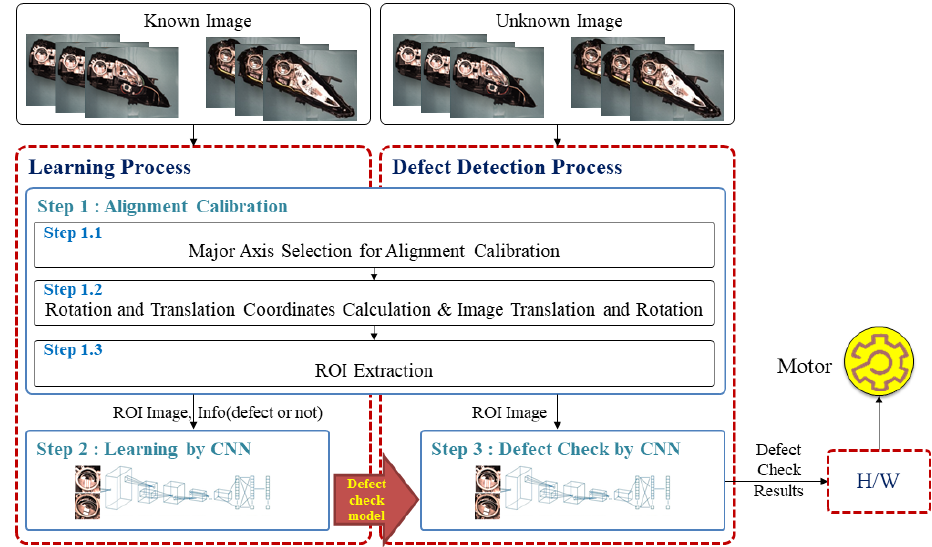
Figure 4. Structure of the defect checker module.